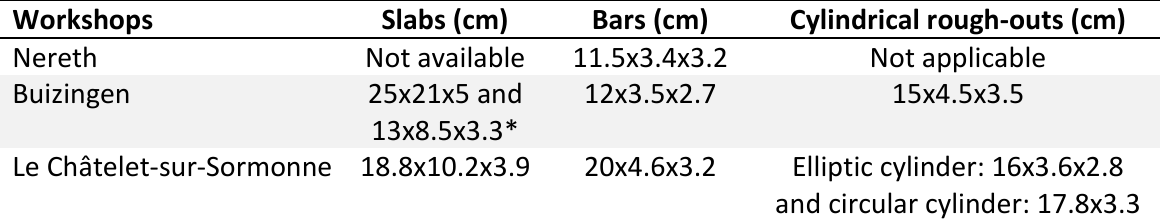
Figure 7: Slabs with V-shaped grooves from (1) Le Châtelet-sur-Somonne and (2) Buizingen. Table 1: Average measurements (L x W x T) of slabs, bars and cylindrical rough-outs from Nereth, Buizingen and Le-Châtelet-sur-Sormonne. * Size of the two well-preserved